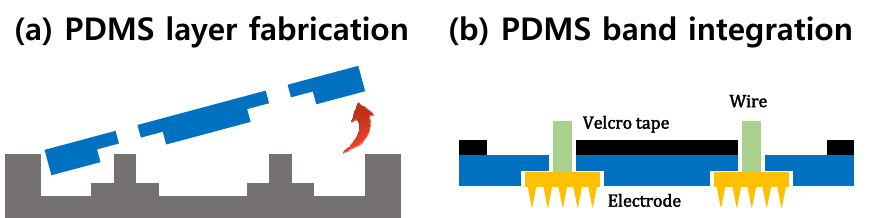
Figure 7. Fabrication process for the PDMS band array. ( a ) Base PDMS layer fabrication; ( b ) the MNA electrode integration and Velcro tape attachment.